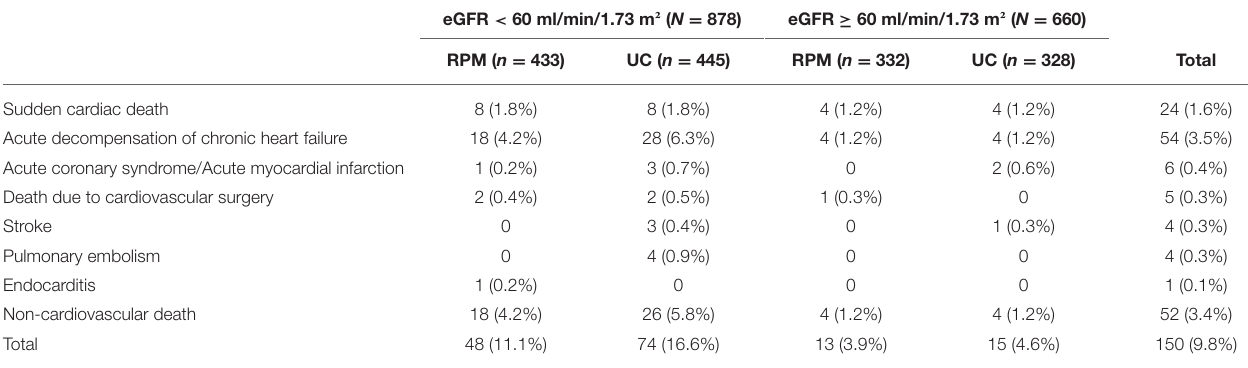
TABLE 4 | Reasons for Death depending on kidney function and study